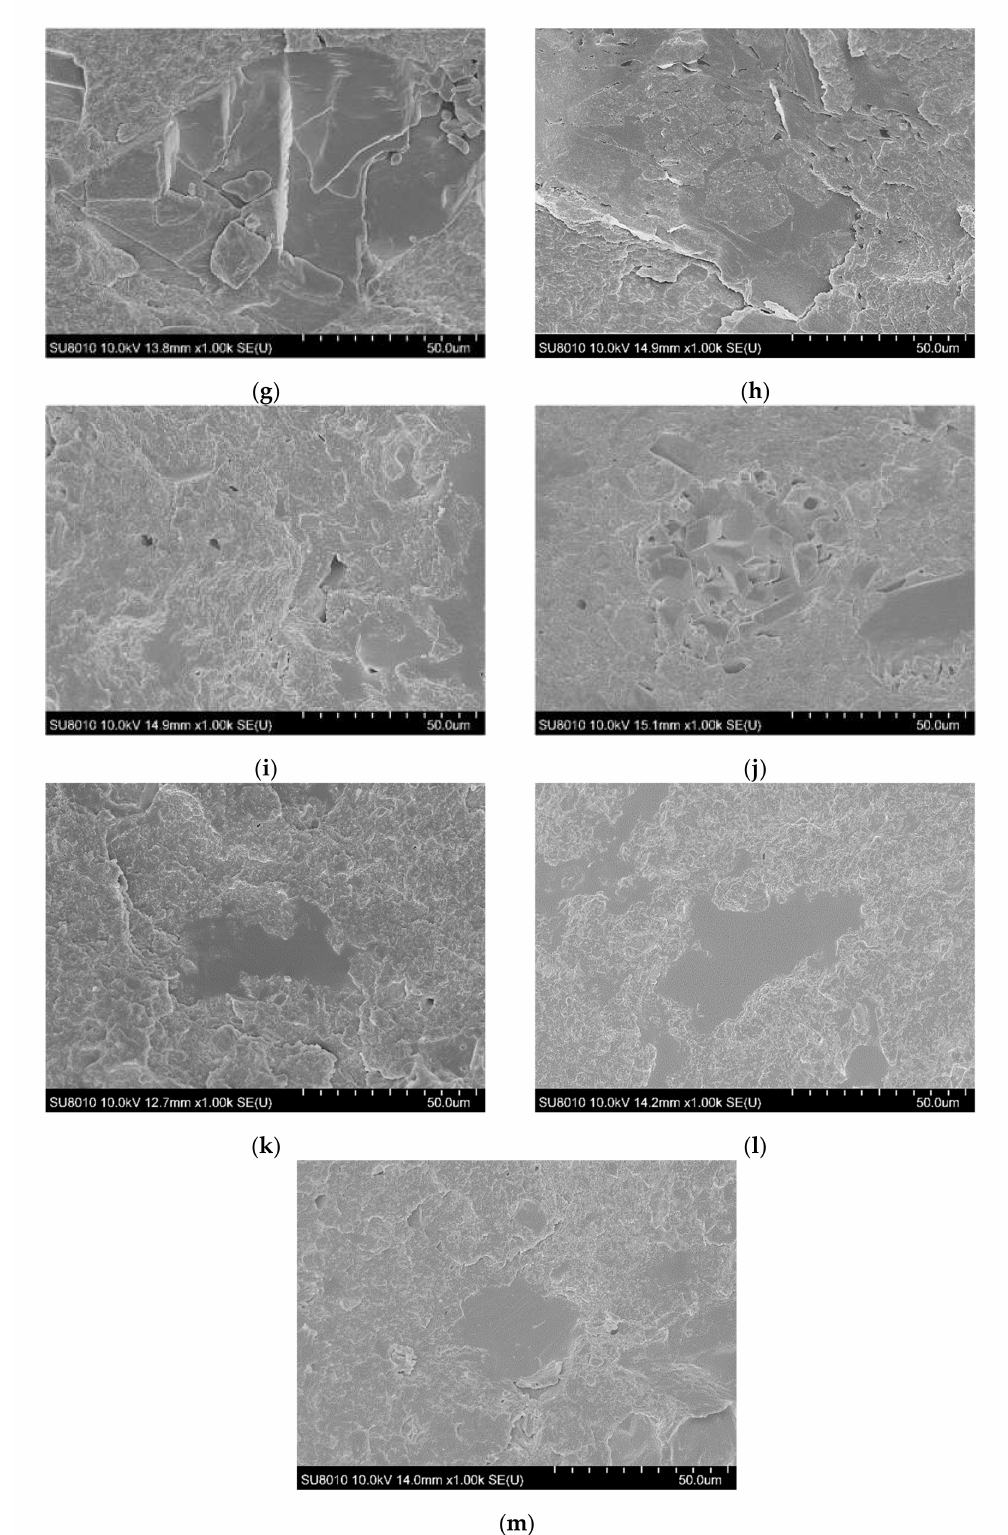
Figure 2. SEM images of fracture surfaces of PVC ( a ), 10APP ( b ), 20APP ( c ), 30APP ( d ), 4n6H ( e ), 4n16H ( f ), 4n26H ( g ), 4n6LHP ( h ), 4n16LHP ( i ), 4n26LHP ( j ), 4n3LHP3ZB ( k ), 4n8LHP8ZB ( l ), and 4n13LHP13ZB ( m